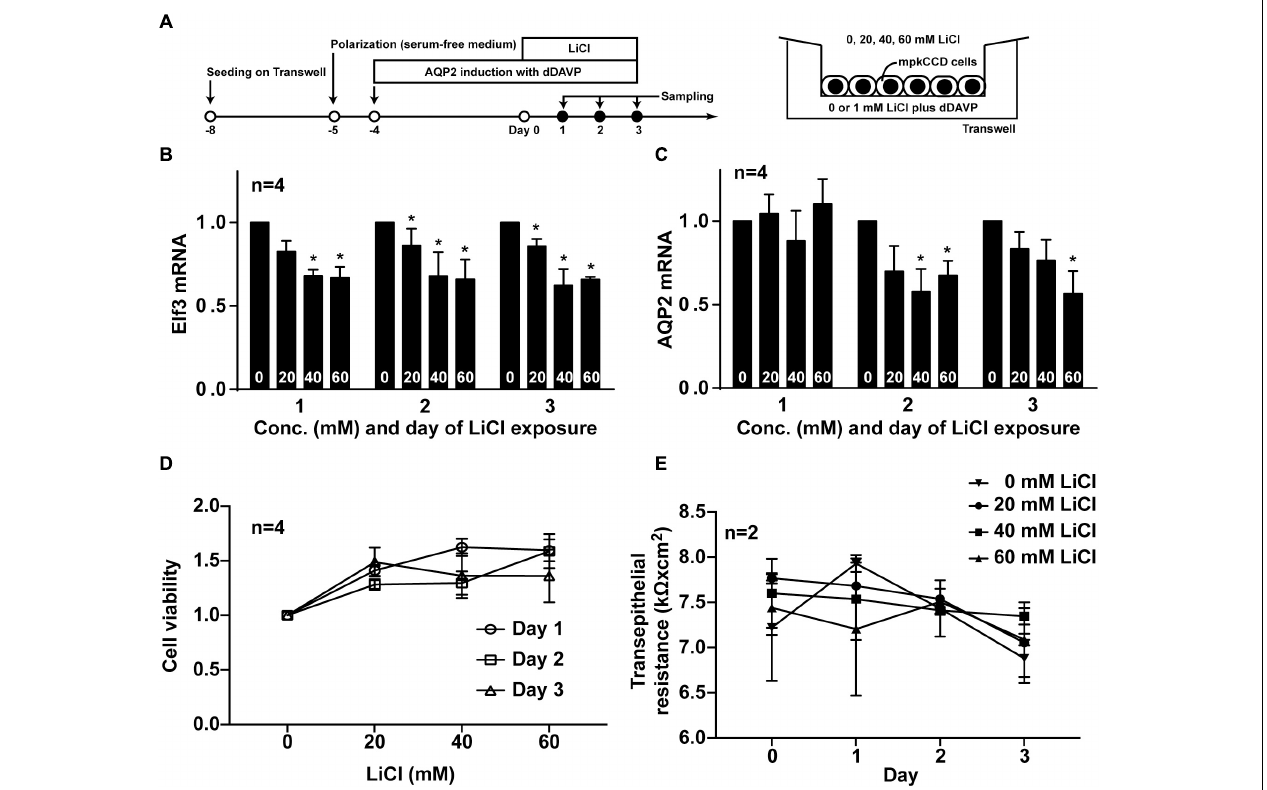
FIGURE 7 | Lithium reduced Elf3 and AQP2 mRNA in the mpkCCD cells. (A) Experimental protocol. (B) Elf3. (C) AQP2 mRNA levels in the mpkCCD cells exposed to the indicated lithium chloride (LiCl) concentrations (0–60 mM) for 1–3 days. (D) Cell viability. (E) Transepithelial resistance values of the mpkCCD cells exposed to lithium chloride. Values are means ± SE, normalized against values of zero mM LiCl on the same day. Asterisk indicates significance ( p < 0.05, t -test) against the values at zero mM LiCl on the same day. Two-way ANOVA was used to assess time- and dose-dependent effects of LiCl.